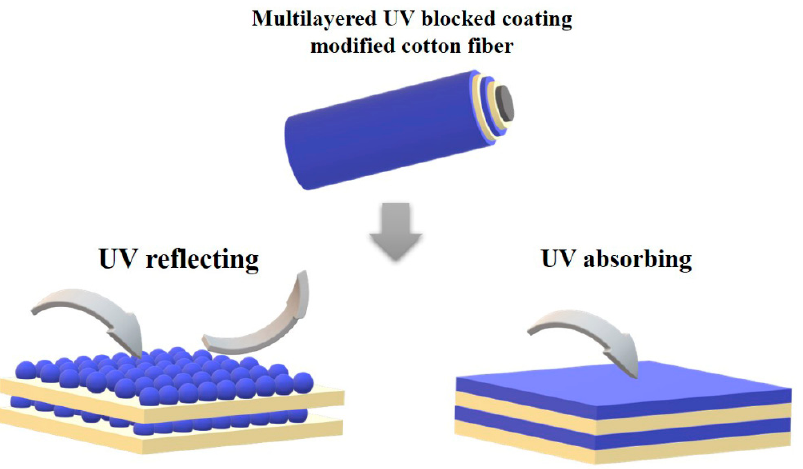
Figure 7. Schematic of UV shielding of LbL self-assembly coating. Table 6. UV resistance of the LbL self-assembly coating on the fabric.